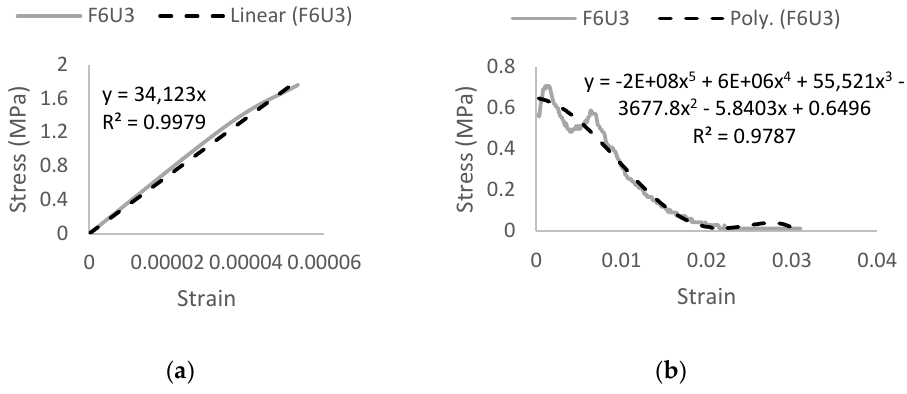
Figure 8. F6U3 uniaxial tension stress–strain curve: ( a ) elastic stage and ( b ) plastic